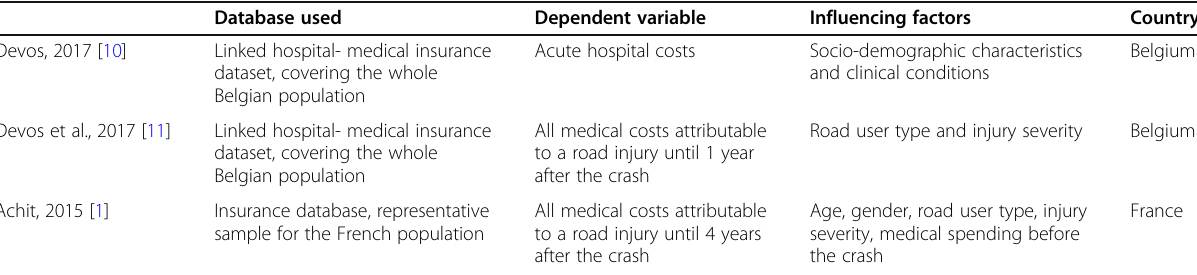
Table 3 Description of the studies that provide more detailed analyses on medical